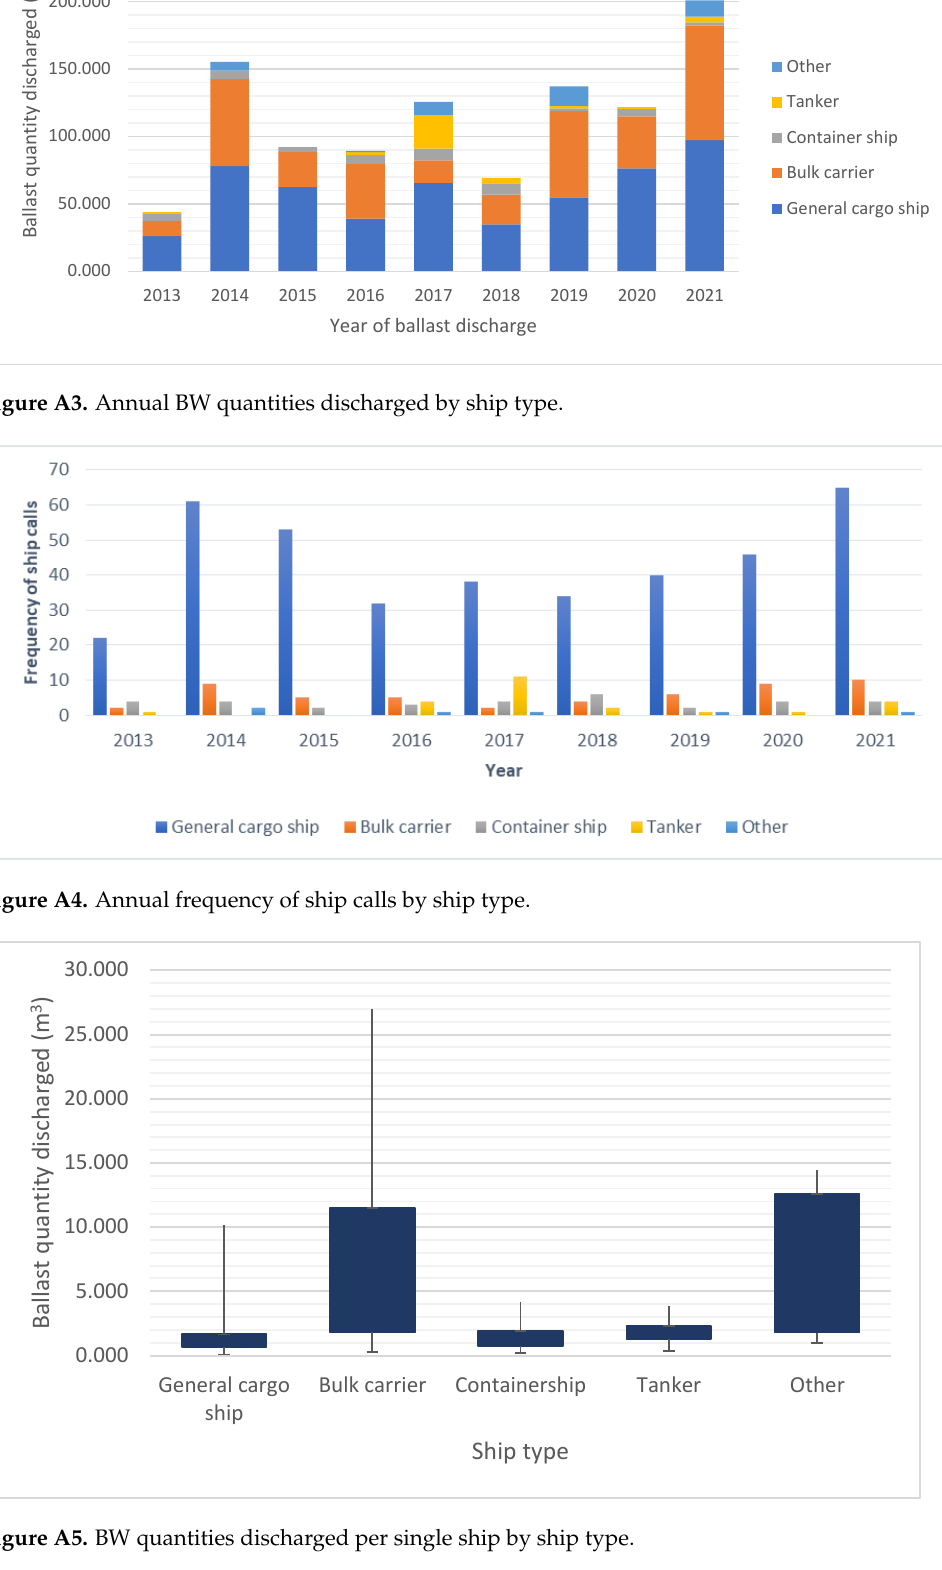
Figure A5. BW quantities discharged per single ship by ship type.